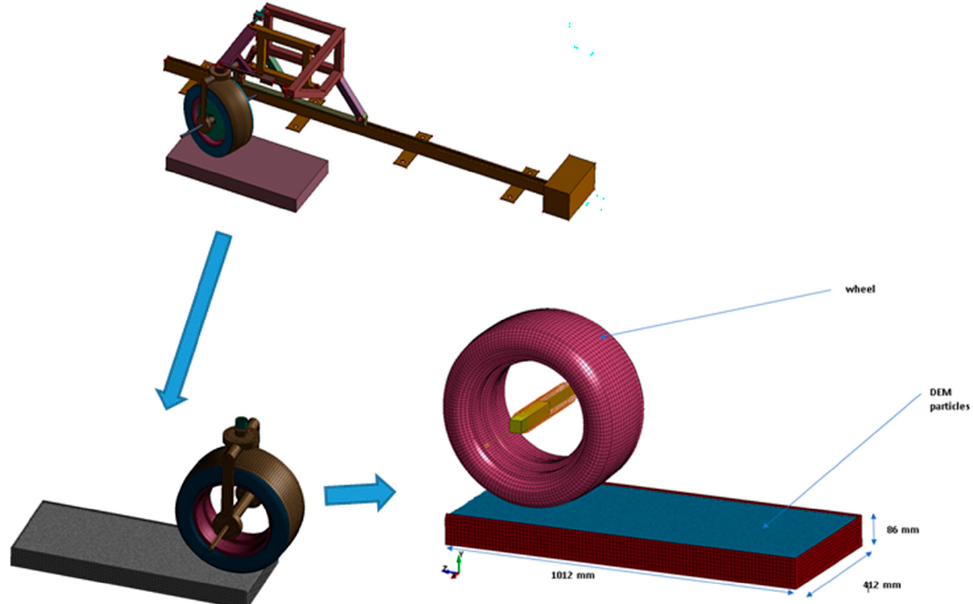
Figure 10. Simplification of the numerical model.